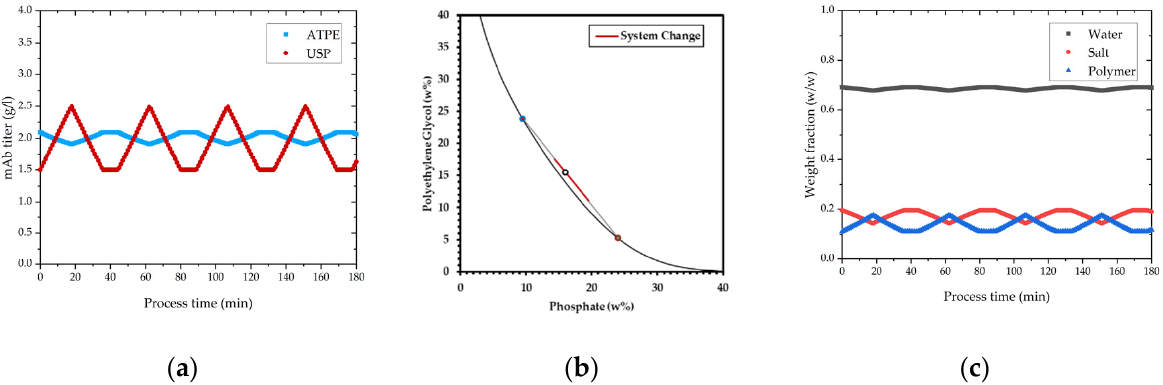
Figure 14. Simulation results for concentration fluctuations ( a ) and concentration compensation by system adjustment ( b , c ).